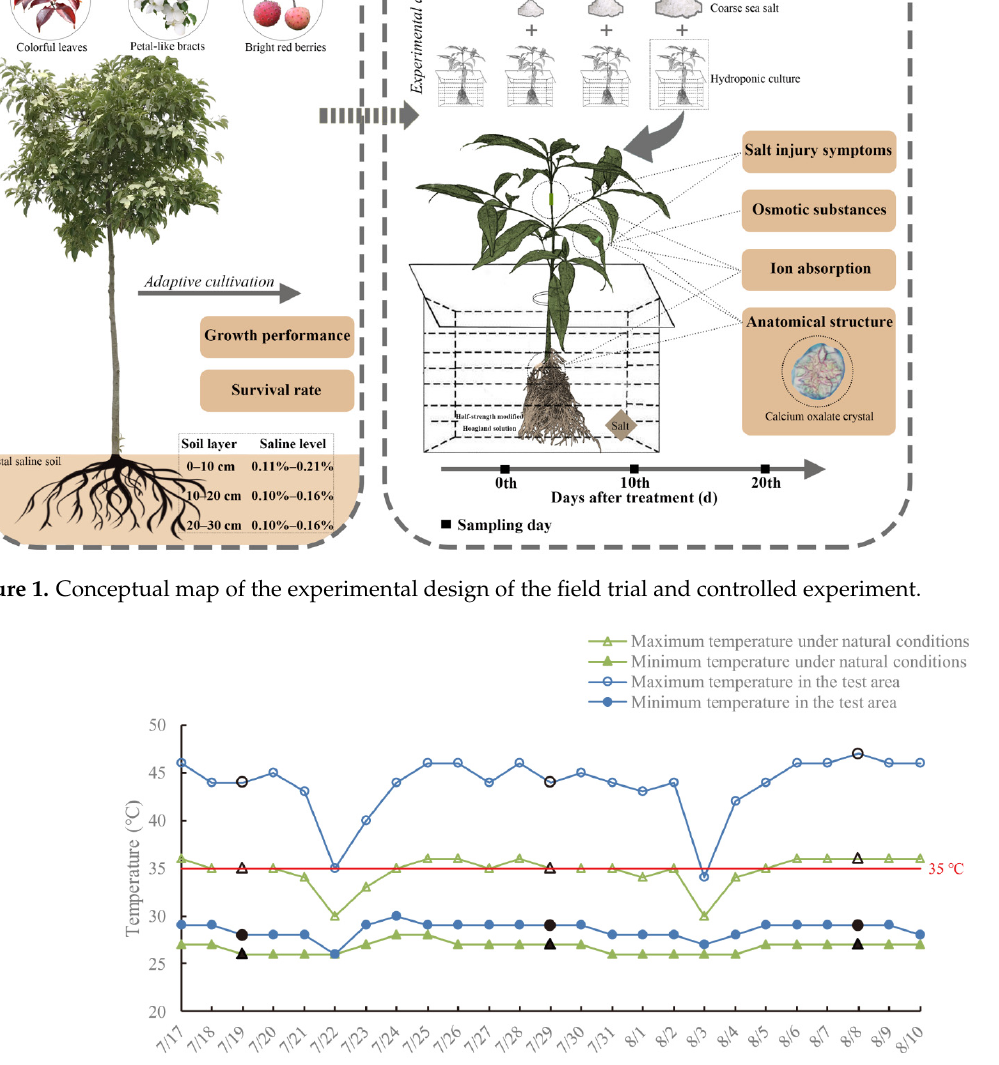
Table 2. Classification system of salt injury degree based on symptoms of seedling. Grade Salt Injury Symptoms